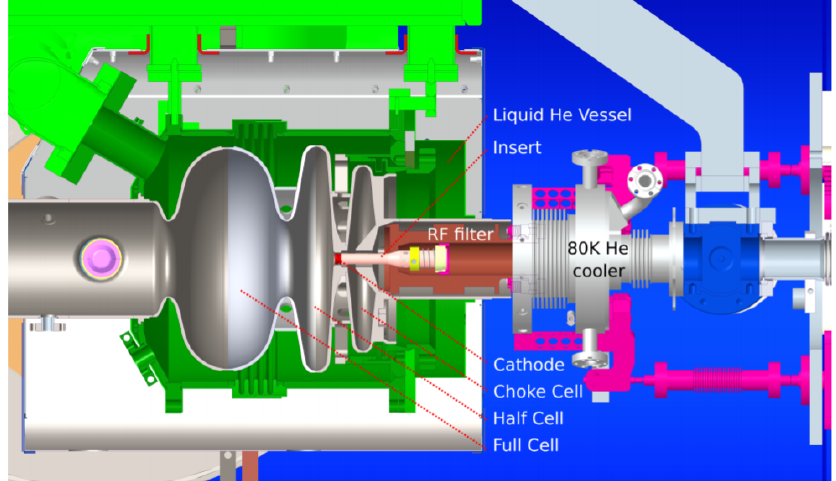
Figure 9. Cross ‐ section of the HZB SRF photoinjector. The cathode is installed in the RF filter and cooled with liquid nitrogen [48].